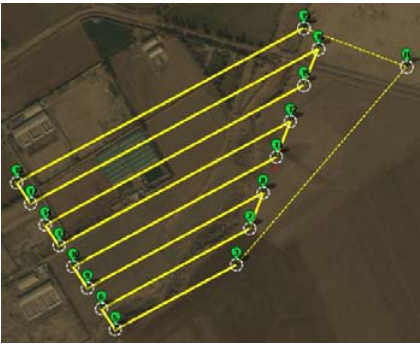
Figure 3. Flight Track (yellow